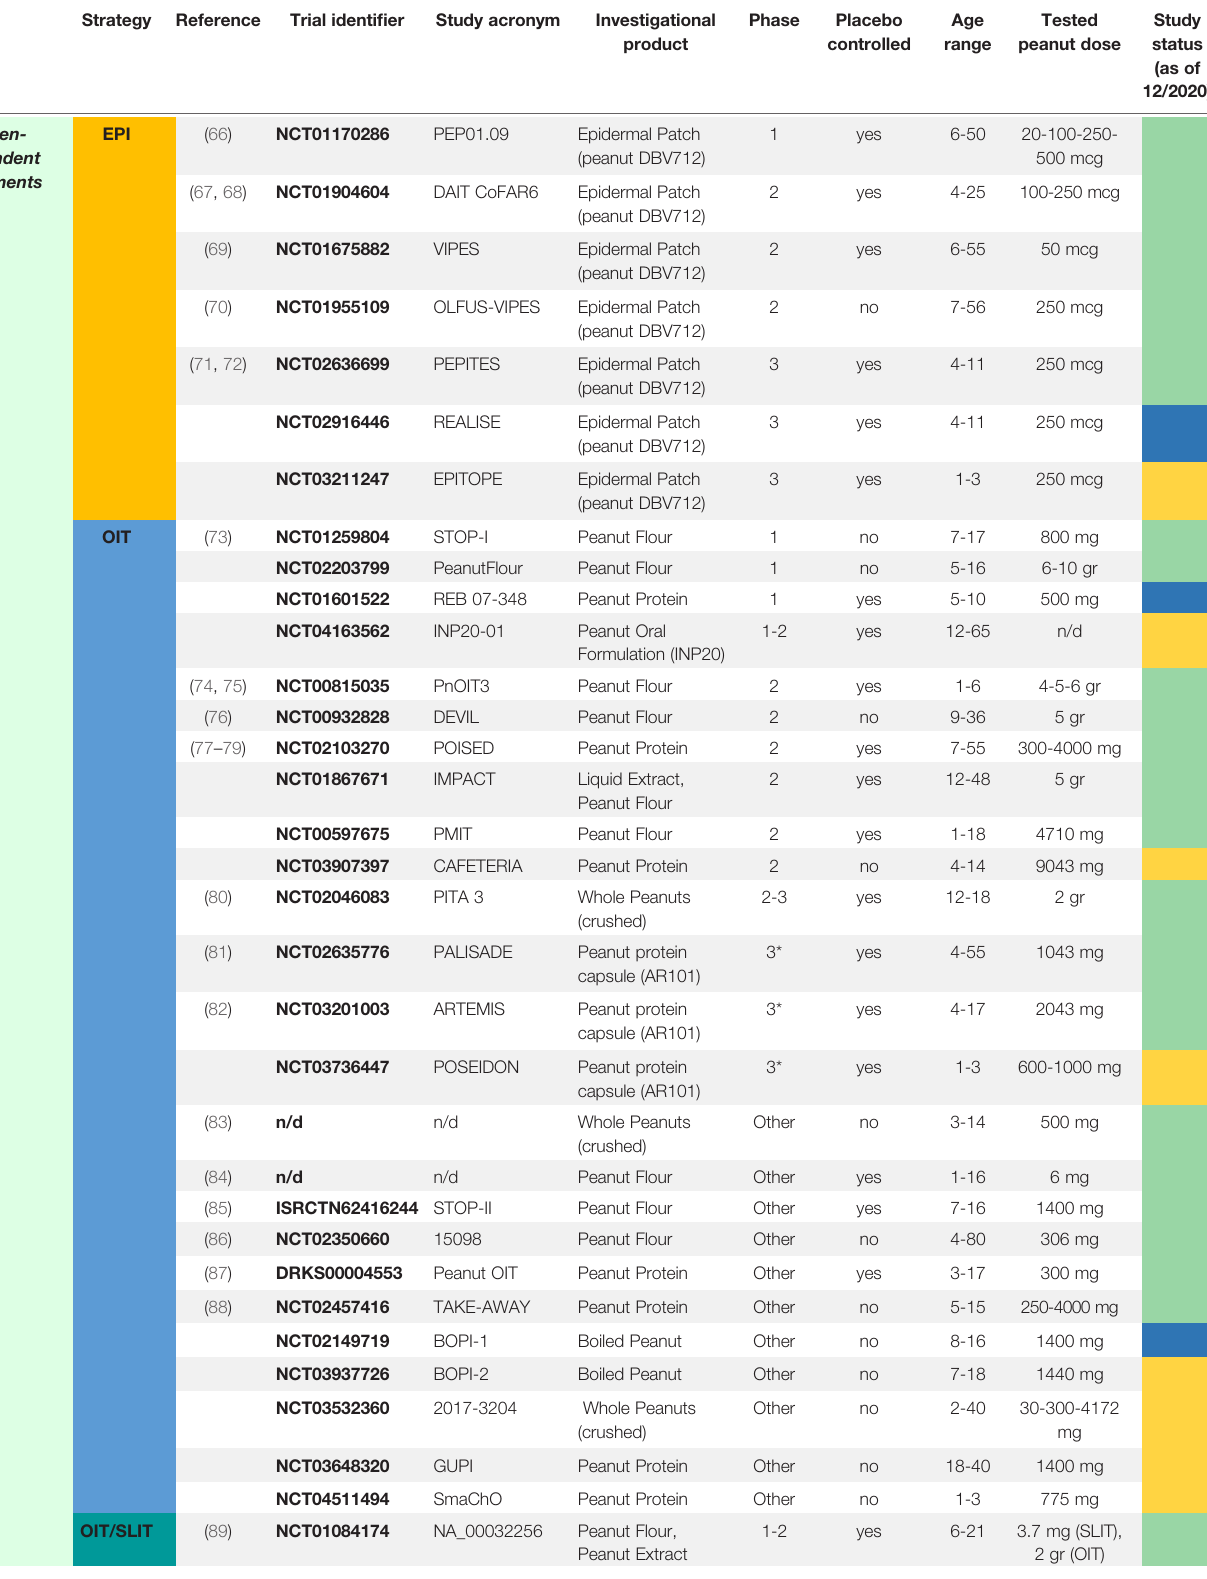
TABLE 1 | List of clinical trials on allergen-dependent and -independent investigational treatments for peanut